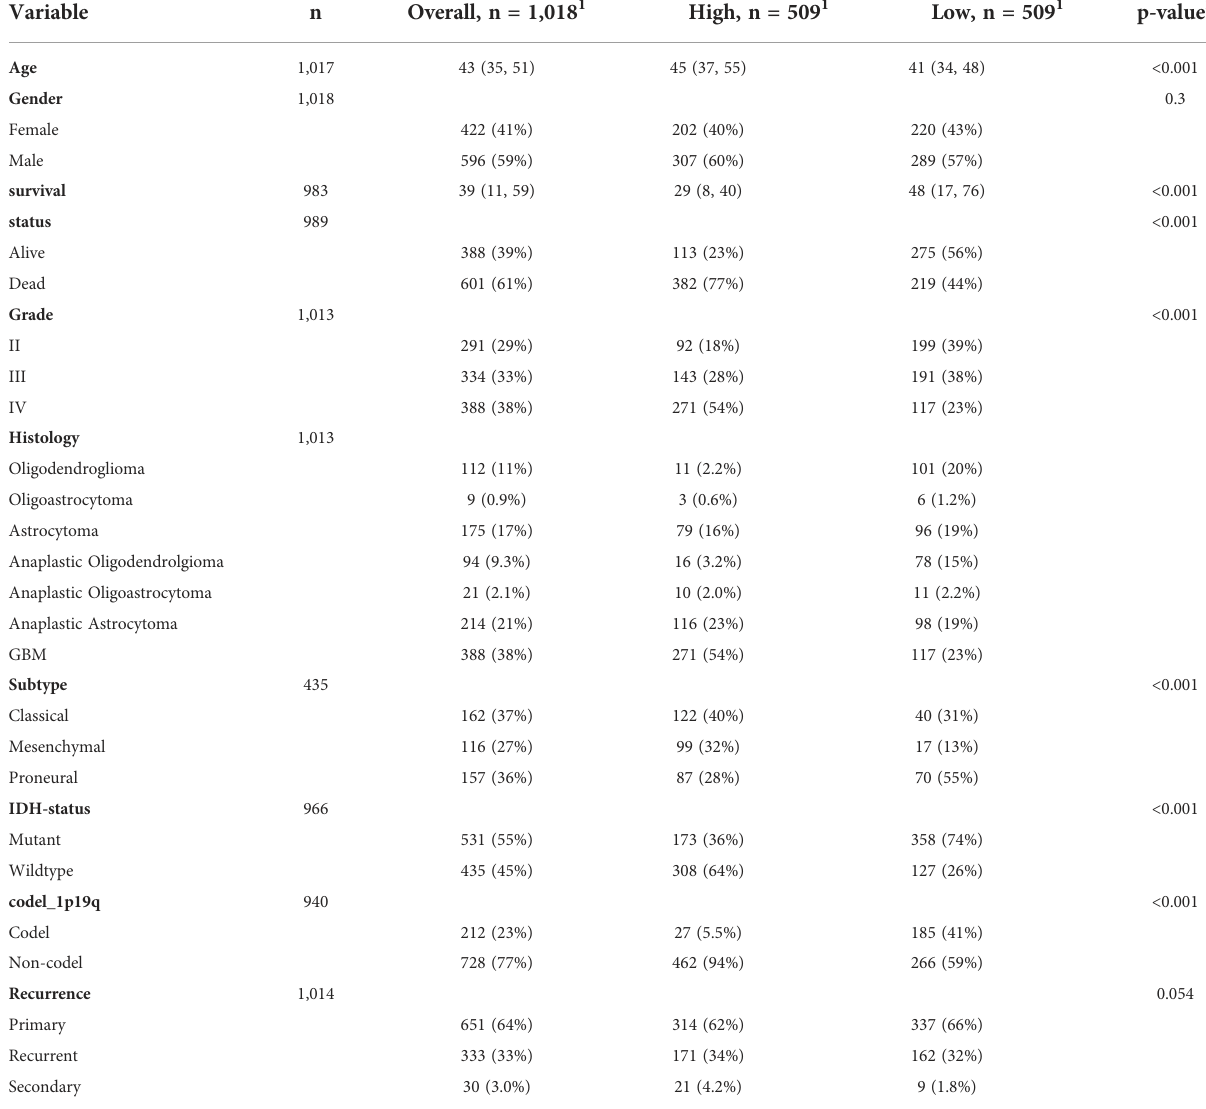
TABLE 1 Clinical characteristics of 1018 glioma patients in the CGGA dataset according to SLC11A1 expression levels.